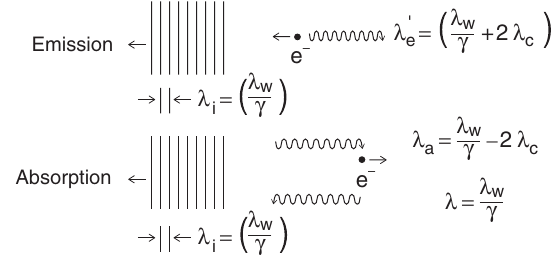
FIG. 2. Differing wavelengths for emission and absorption. Photons moving with the electrons through a periodic transverse magnetic field can also be absorbed if their wavelength λ is shorter by 2 λ than the period of the Lorentz-contracted wave c in the electron rest frame. Scattering of photons with this reduced initial wavelength in the direction of the Lorentz contracted periodic field is strongly enhanced by the high density of photons in their final state leading to a transition rate for absorption of these “ blue shifted ” photons equal in value to the rate for amplification of the “ redshifted ” emitted photons of wavelength λ e